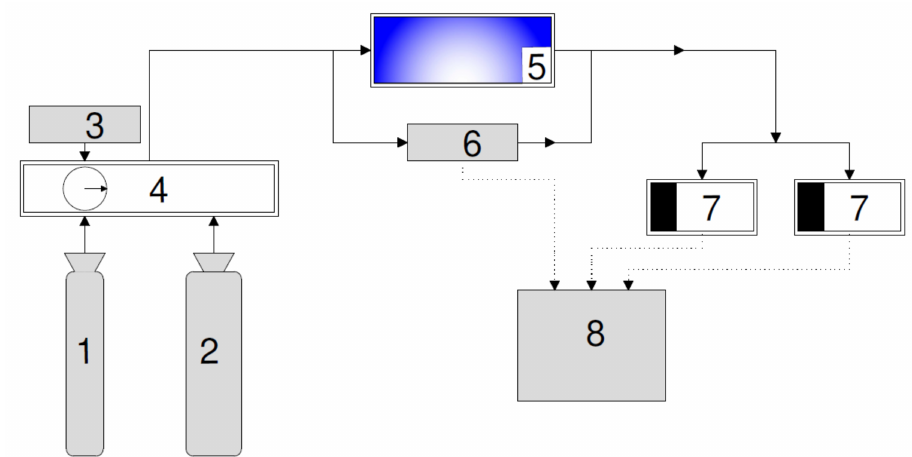
Figure 2. A schematic diagram of the test setup used for NO x and O 3 reduction: ( 1 ) NO source, ( 2 ) zero air generator, ( 3 ) ozone generator, ( 4 ) multigas calibrator, ( 5 ) reactor, ( 6 ) mass flow controller, ( 7 ) NO x and O 3 analyzer, and ( 8 ) data